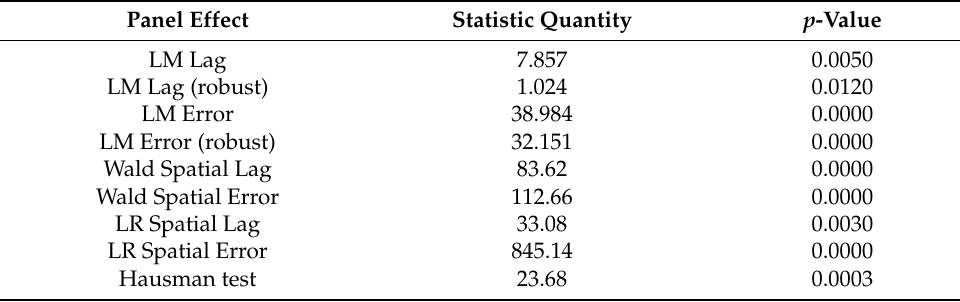
Table 5. Selection test of the spatial metrology model.